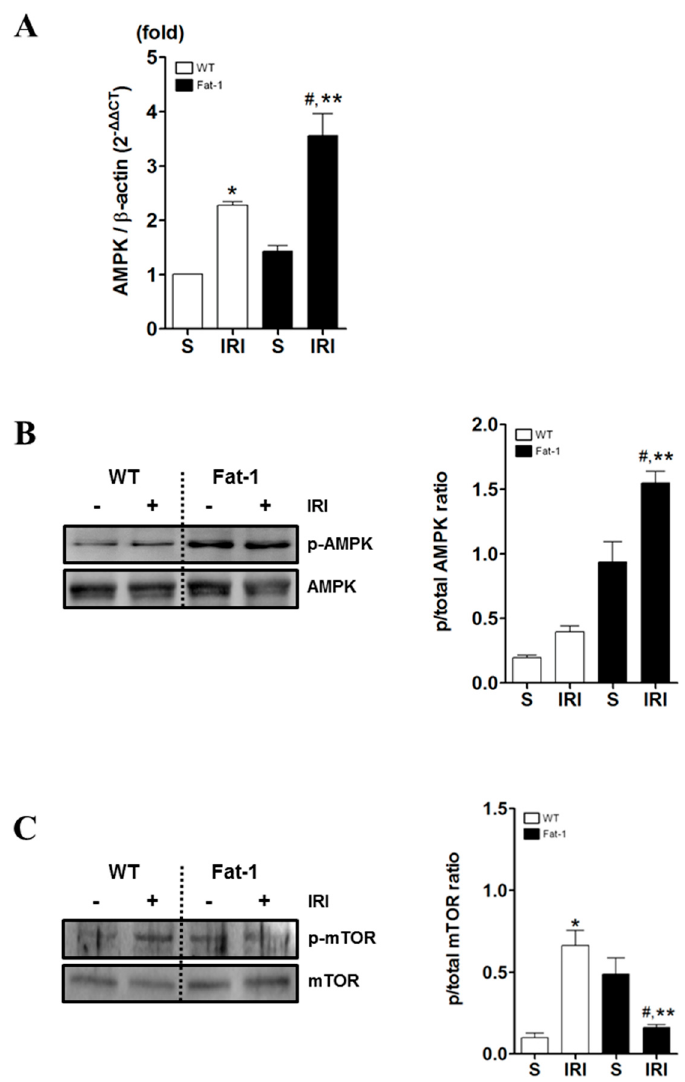
Figure 5. AMP-activated protein kinase (AMPK) and mammalian target of rapamycin (mTOR) expression in IR kidney. Renal expression of AMPK and mTOR. ( A ) Real-time PCR of AMPK in kidney tissue; ( B ) Representative picture and densitometry analysis of western blot of p-AMPK in kidney tissue; and ( C ) Representative picture and densitometry analysis of mTOR in kidney section. Right panel: quantification of densitometry ( n = 7–8). Data were normalized using β -actin. * p < 0.05 vs. WT-sham kidney, # p < 0.05 vs. fat-1-sham kidney, ** p < 0.05 vs. WT-IR kidney. Bar represents mean ± S.D.